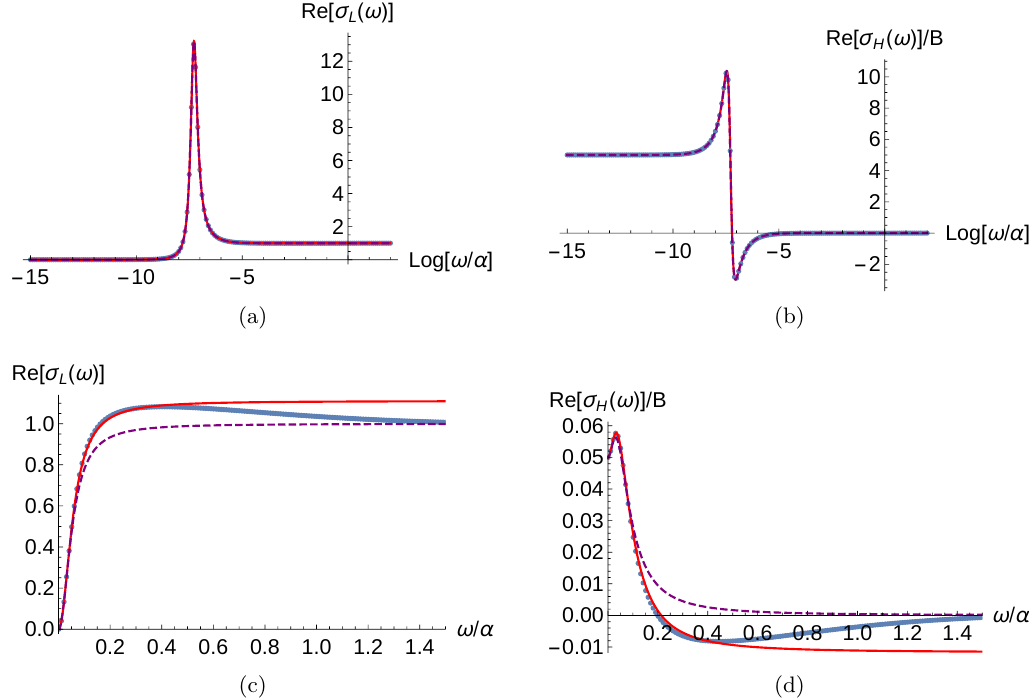
Figure 2 : The real parts of the AC charge conductivity as a function of frequency for two choices of charge density and magnetic (cid:12)eld. Blue dots are data, the solid red line is our analytic result and the purple dashed line is the result of standard magnetohydrodynamics (see appendix A). Upper: the longitudinal (left) and Hall (right) AC conductivities with B=(cid:11) 2 = 1 = 100 and (cid:26)=(cid:11) 2 = 1 = 20. Lower: the longitudinal (left) and Hall (right) AC conductivities with B=(cid:11) 2 = 1 = 20 and (cid:26)=(cid:11) 2 = 1 = 100 i.e. B > (cid:26)